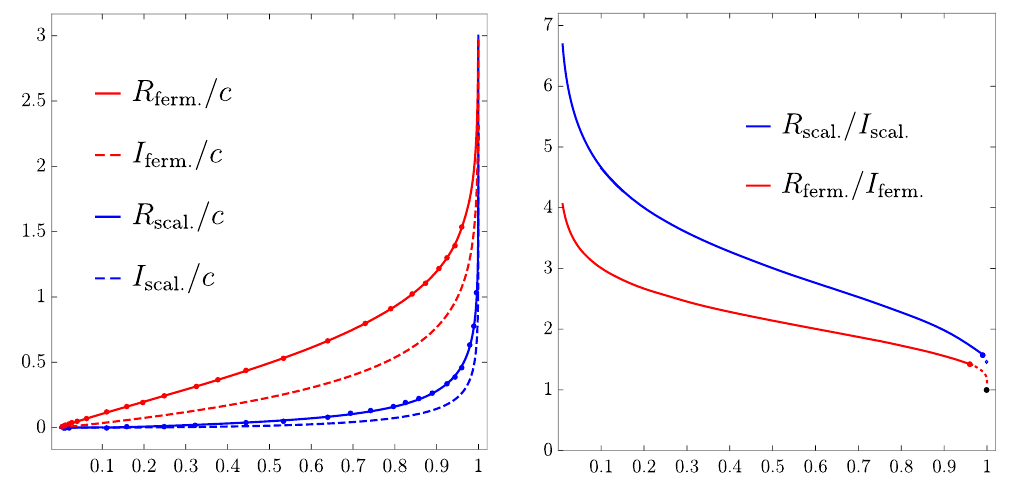
Figure 2 . We plot the reflected entropy and mutual information for two intervals A, B , as a function of the cross-ratio for a free fermion (red) and a free scalar (blue). In the right we plot the quotient between both quantities for each model. The black dot corresponds to the limit η = 1 , where both quotients should tend to one. The red and blue dots correspond to the greatest values of η for which we numerically evaluated the reflected entropy for each model. The red dotted line has been computed using the general-CFT formula eq. (3.8) and eq. (3.9) and is valid for η → 1 . In the case of the scalar, the curve becomes very steep near η → 1 because of U ( τ ) . For instance, the small blue diamond shown in the figure corresponds to the value η = 0 . 9999999999999999 , for which R scal . /I scal . = 1 . 470488